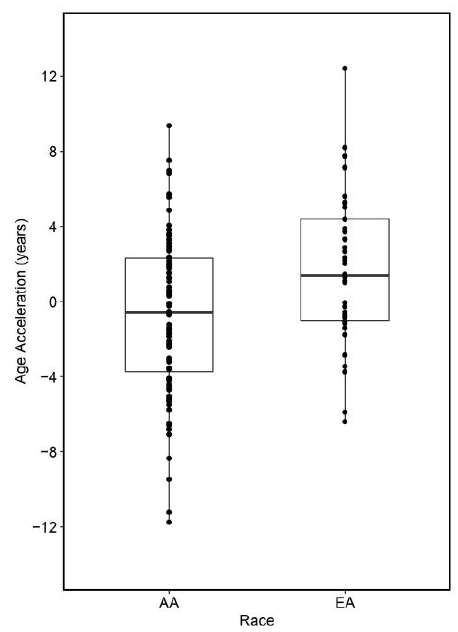
Figure 1. Summary of epigenetic age acceleration analysis between AA and EA normal colon. Positive values indicate samples that are epigenetically older than expected.